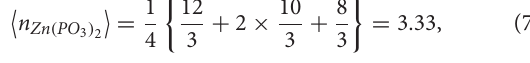
FIGURE 11 | The fragility indices of [Al(PO 3 ) 3 ] y [NaPO 3 ] 1 − y and [Zn(PO 3 ) 2 ] y [NaPO 3 ] 1 − y plotted as a function of the connectivity coarse-grained to include both edge-sharing and corner-sharing configurations as described in the text. Also shown are the collective data from previous figures: sodium phosphates (solid circles), chalcogenides (open circles), alkali borates (open squares), alkali germanates (open diamonds), and alkali silicates (solid diamonds). The inset shows the three possible configurations of a Zn cation in Zn(PO 3 ) 2